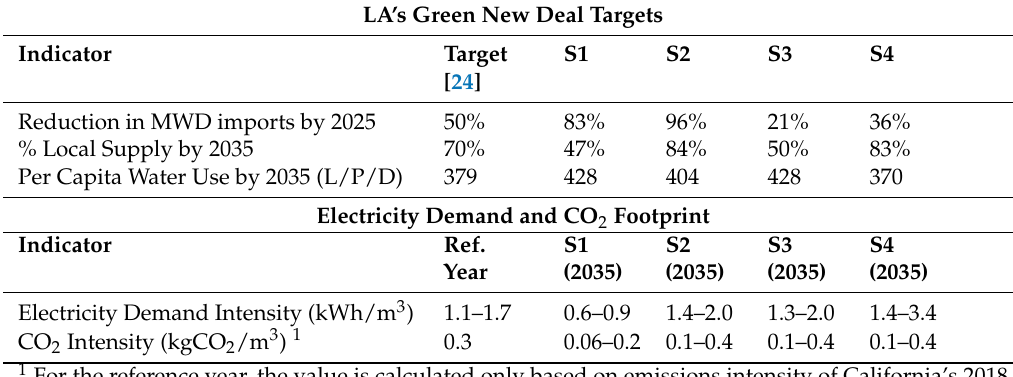
Table 5. Summary of performance of studied scenarios in achieving LA’s sustainability targets, as well as electricity demand intensity and emissions intensity of water for year 2035 of each